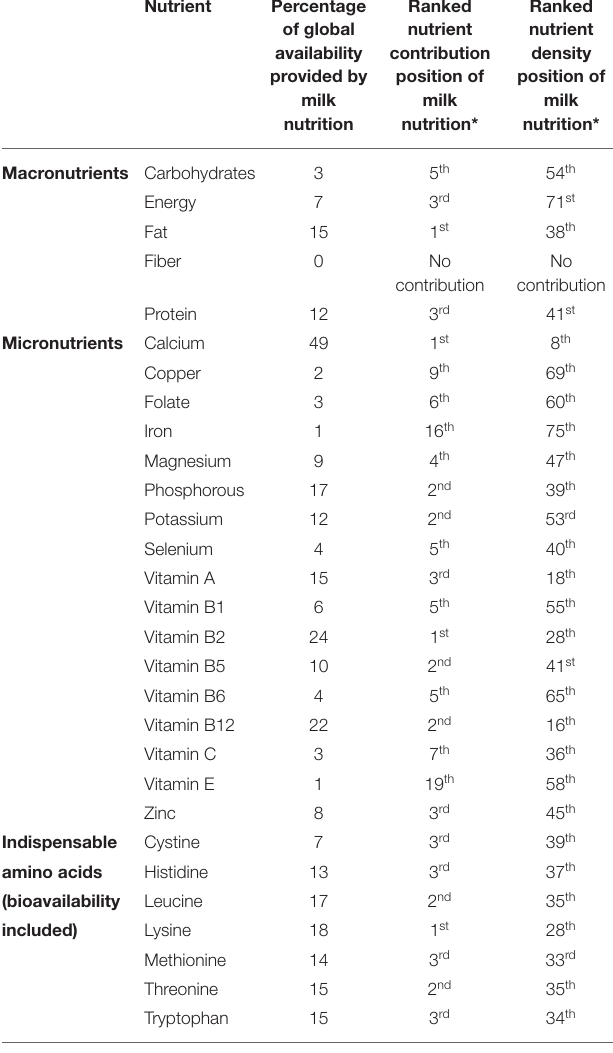
TABLE 1 | Contribution of milk production to 2018 global nutrient availability.